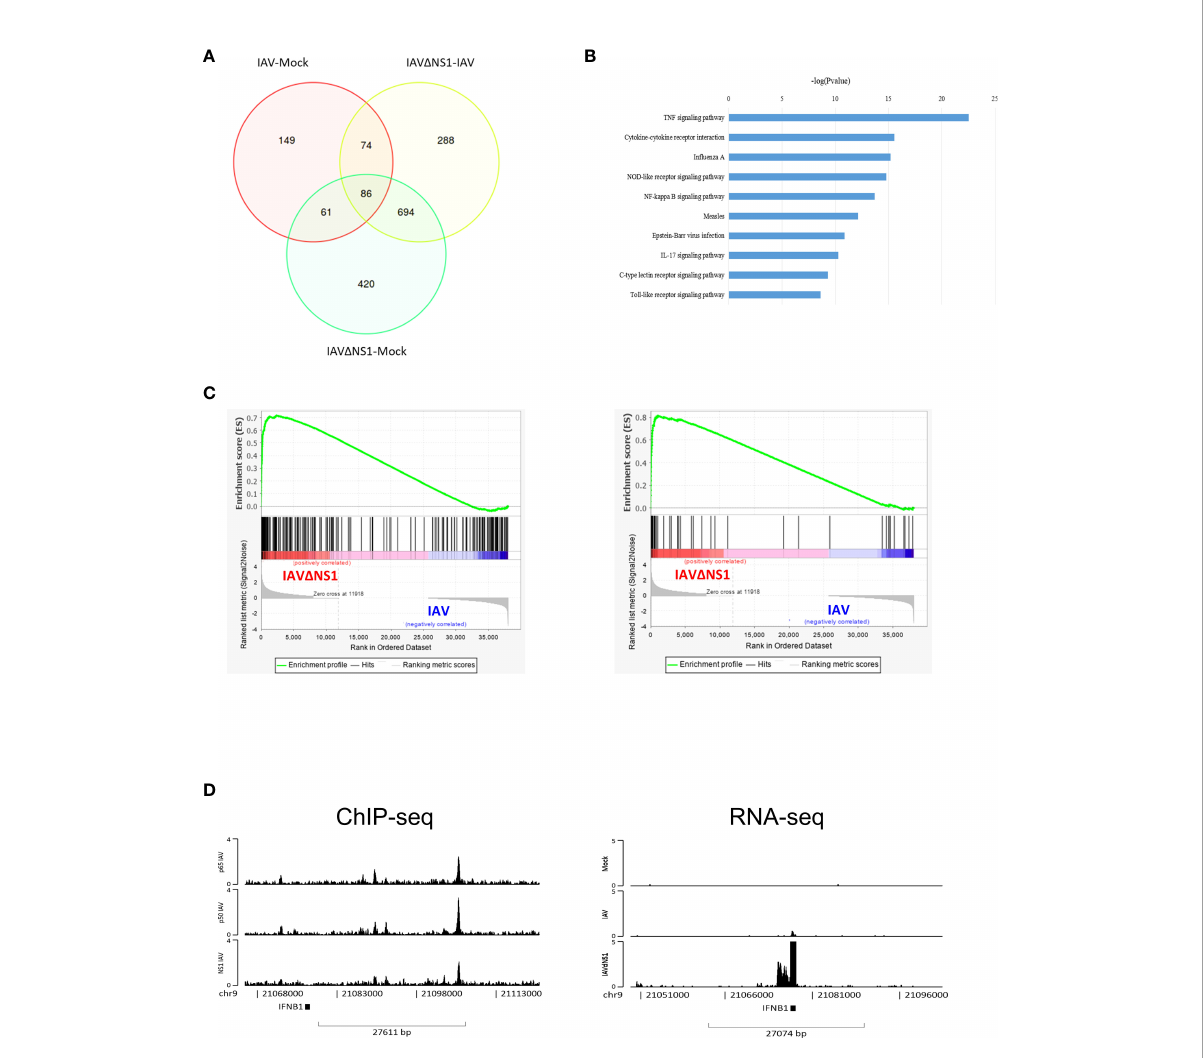
FIGURE 2 Deletion of the NS1-triggered upregulation of NF- k B signaling. (A) Venn plot of differentially expressed genes (DEGs) among the mock, IAV, and IAV D NS1 groups. (B) Bar chart of the selectively enriched pathways for DEGs between and IAV. (C) Gene set enrichment analysis of the comparison of IAV D NS1 and IAV. (D) Genomic binding of NF- k B and NS1 at the IFNB1 gene loci derived from the ChIP-seq data. IFNB1 mRNA abundance derived from the RNA-seq data for the mock, IAV, and IAV D NS1